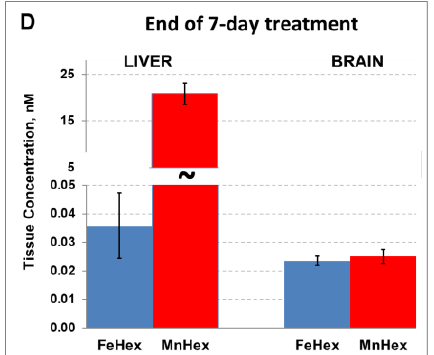
Figure 5. The 7-day rat PK study in healthy rats. FeHex and MnHex were given to rats SC for 7 days every 12 h at 0.225 mg / kg. ( A ) FeHex single plasma PK within the first 12 h was done at 10 min, 30 min, and 1 h 2 h, 4 h, and 12 h after the 1st injection. ( B , C ) Plasma levels were followed before and 2 h after each subsequent injection; solid line represents the predicted profile after first-order absorption / first-order elimination simulation by WinNonlin software. ( D ) Liver and brains were taken for analysis 12 h after the last injection. Error bars depict single standard deviation. Liver, FeHex vs. MnHex, p = 0.004. Brain, FeHex vs. MnHex, p = 0.548.